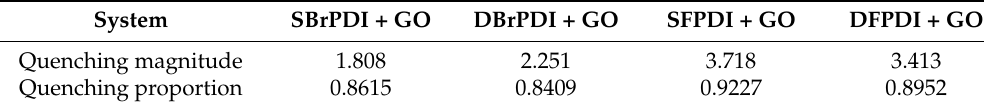
Table 1. Fluorescence quenching parameters of dyes and GO (0.8 mg/mL).